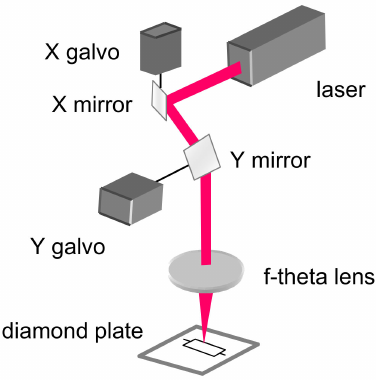
Figure 2. Scanner system.